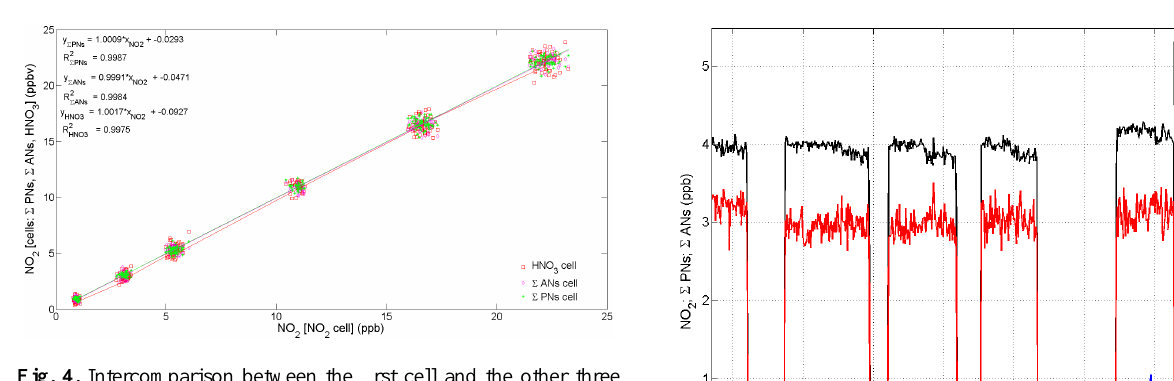
Fig. 4. Intercomparison between the first cell and the other three Figure 4. Intercomparison between the first cell and the other three cells when the common 2 cells when the common inlet sampled different concentrations of inlet sampled different concentrations of NO 2 , sent using the calibration system of the TD-3 NO 2 , sent using the calibration system of the TD-LIF. LIF. 4 5